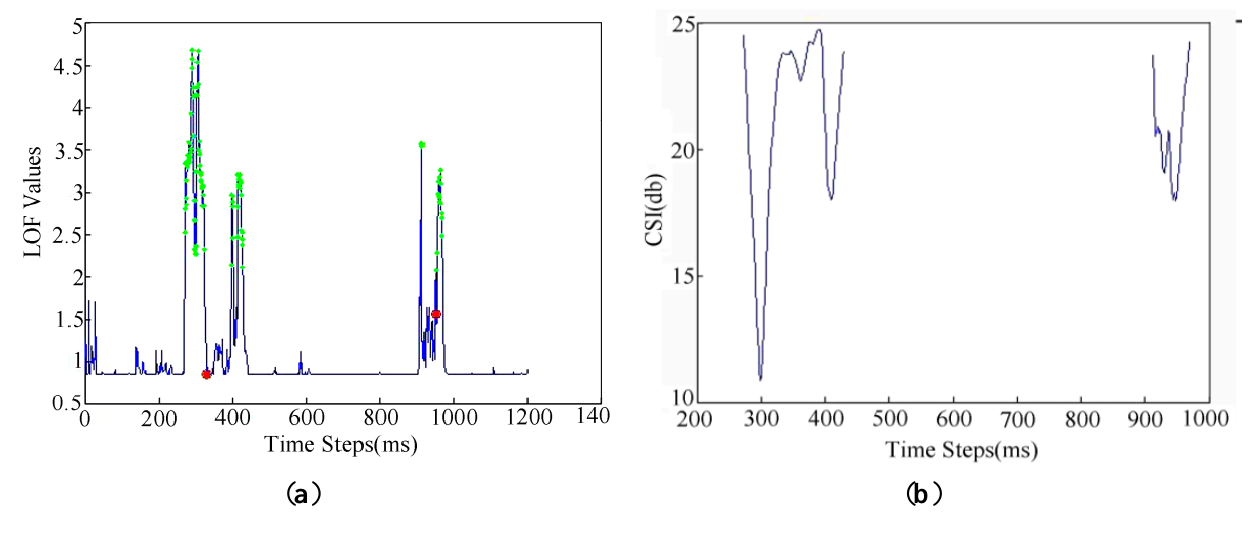
Figure 3. An example of online segmentation for two actions. ( a ) Two actions’ LOF subplots; ( b ) The segmentation result for two actions’ CSIs subplots by our